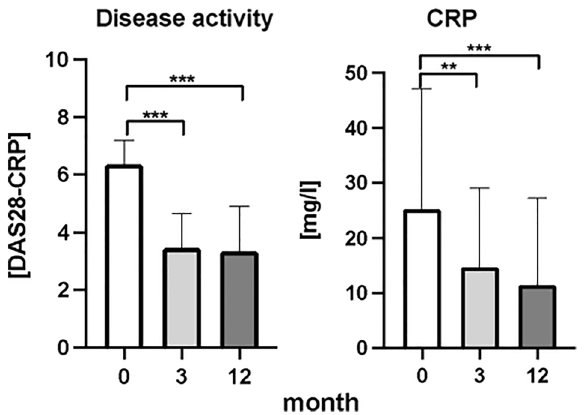
Figure 1. Clinical status of patients with rheumatoid arthritis: disease activity score (DAS28) and C-reactive protein (CRP), before the bDMARDs treatment initiation and 3 and 12 months during ongoing treatment ( p < 0.05 = *, p < 0.01 = **, p < 0.001 =